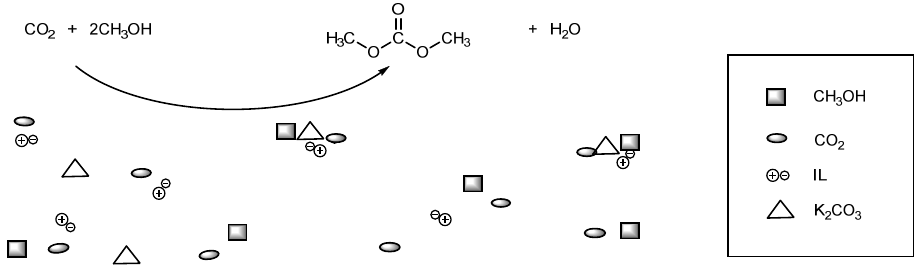
Table 2. Effects of ionic liquids on bond distances and bond angles of CO 2 [61]. (Adapted with per- mission from Ref. [61], 2012, Elsevier)